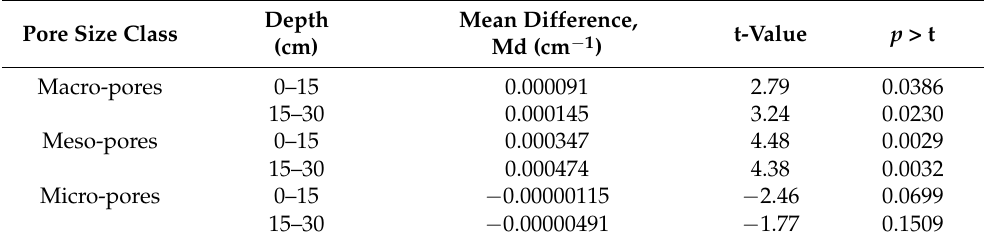
Table 2. Results of paired t -test analysis (mean difference, Md) comparing pore size distribution (PSD) between untilled (NT) and conventionally tilled (CT) soils at 0–15 and 15–30 cm depths for macro-, meso-, and micro-pore classes. Depth Mean Difference, t-Value p > t Pore Size Class (cm) Md (cm − 1 ) Macro-pores 0–15 0.000091 2.79 0.0386 15–30 0.000145 3.24 0.0230 Meso-pores 0–15 0.000347 4.48 0.0029 15–30 0.000474 4.38 0.0032 Micro-pores 0–15 − 0.00000115 − 2.46 0.0699 15–30 − 0.00000491 − 1.77 0.1509